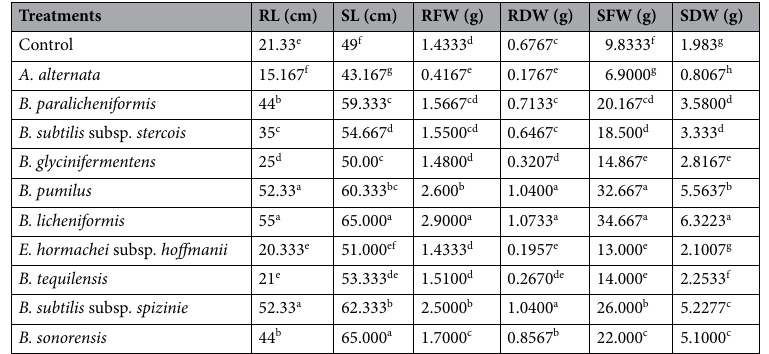
Table 3. Effect of selected bacterial strains on tomato plant growth following A. alternata infection. RL root length, SL shoot length, RFW root fresh weight, RDW root dry weight, SFW shoot fresh weight, SDW shoot dry weight. All the values are the mean of three replicates and bearing different letters in the same column are significantly different at p ≤